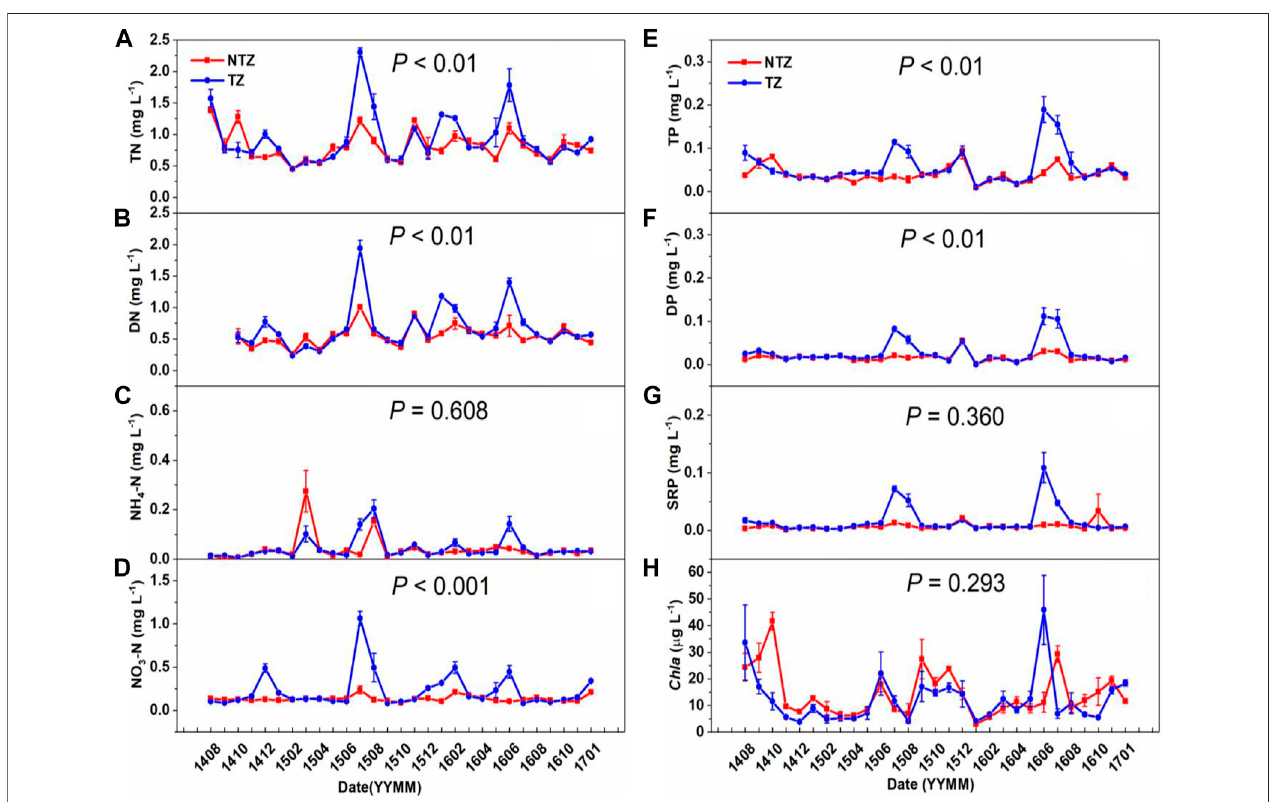
FIGURE3| Waterchemicalparametersoftwozones(NTZ,non- Trapa zone;TZ, Trapa zone;numberofreplicates:4). (A) totalnitrogen; (B) dissolvednitrogen; (C) ammonium nitrogen; (D) nitrate nitrogen; (E) total phosphorus; (F) dissolved phosphorus; (G) soluble reactive phosphorus; (H) chlorophyll a.